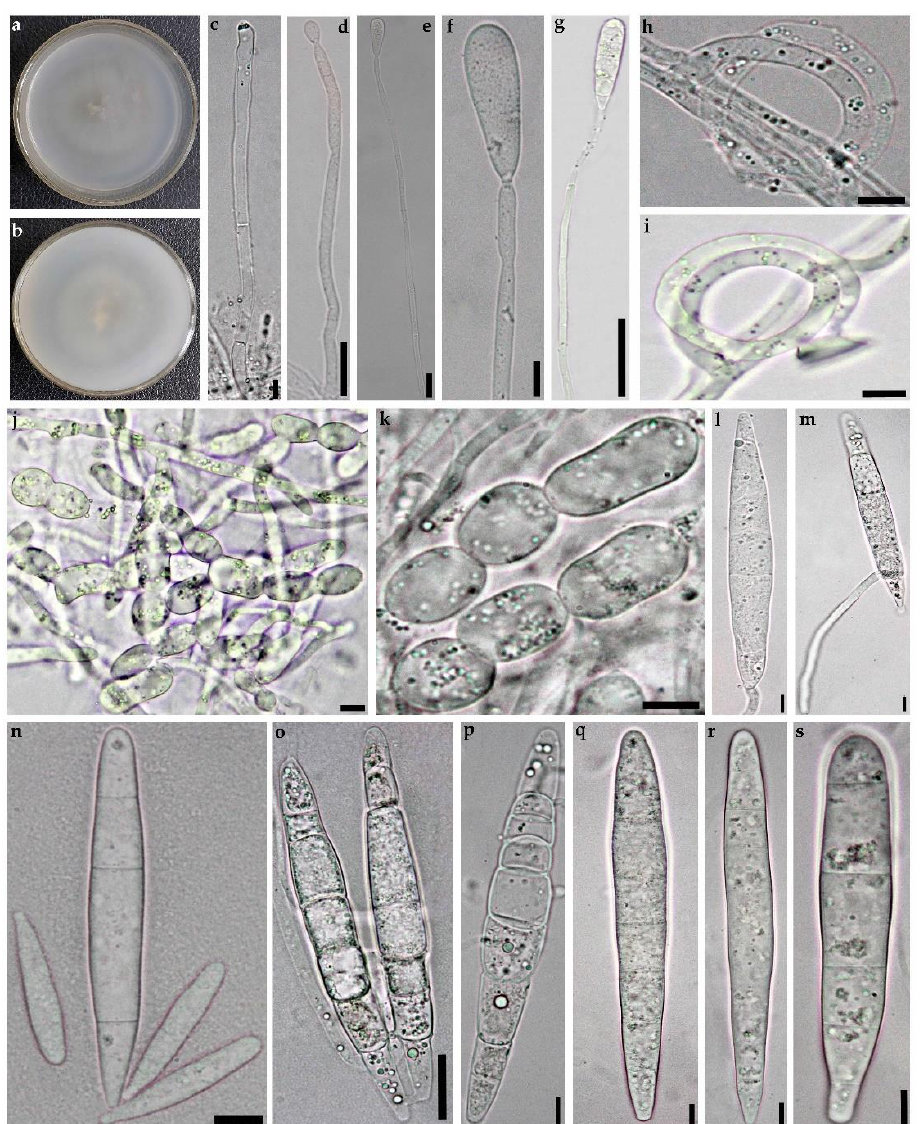
Figure 3. Arthrobotrys hyrcanus (IRAN 3650C). ( a , b ) colony; ( c ) conidiophore; ( d – g ) conidiophore with conidia; ( h , i ) adhesive network; ( j , k ) chlamydospore; ( l , m ) germinating primary conidia; ( n ) primary and secondary conidia; and ( o – s ) primary conidia. Scales bars ( c – s ) 20 µm. Table 3. Diagnostic characters of Arthrobotrys hyrcanus , sp. nov., and closely related species. Refer- ence: Yu et al. [28] and this study.